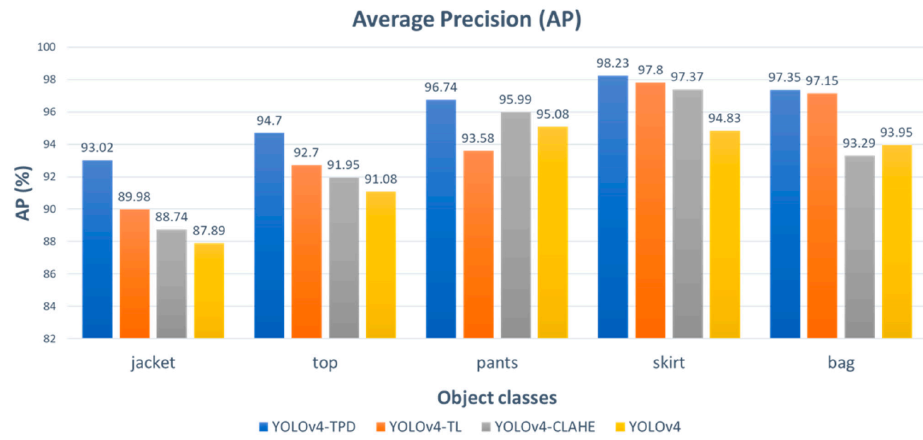
Figure 5. The detection results of the five categories of apparel. The total detection time of the YOLOv4-TPD for fifty images was 781.654 milliseconds. The average time for one image was 15.633 milliseconds, which was equal to 64 frames